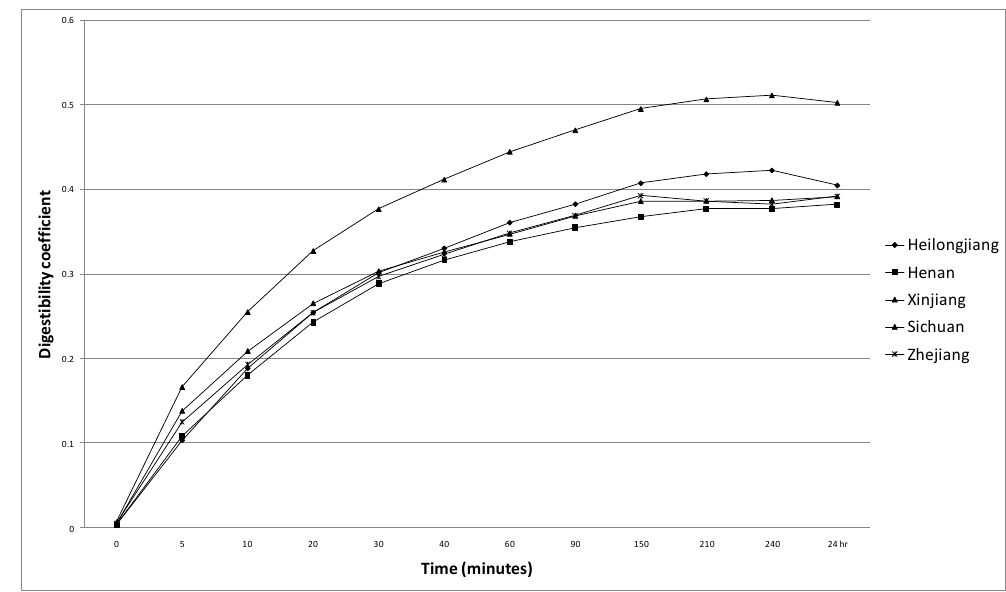
Figure 1. In vitro starch digestibility